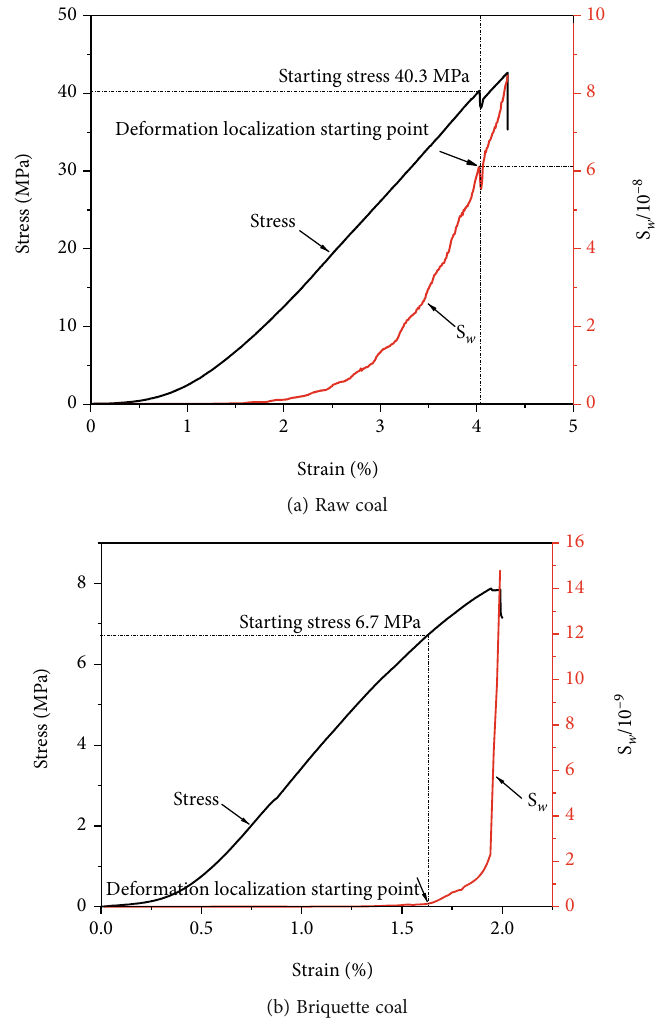
Figure 7: Statistical indicator